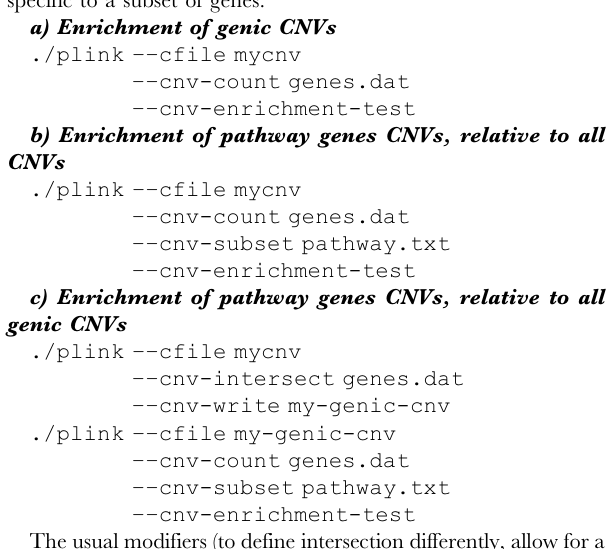
Table S4 Deletion in meta-controls events called in four